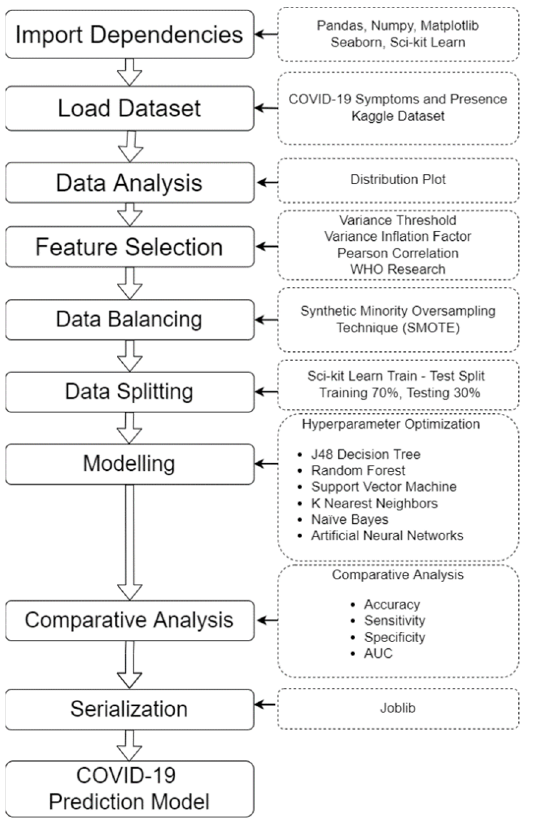
Figure 1. The Block Diagram of the process of machine learning modeling.